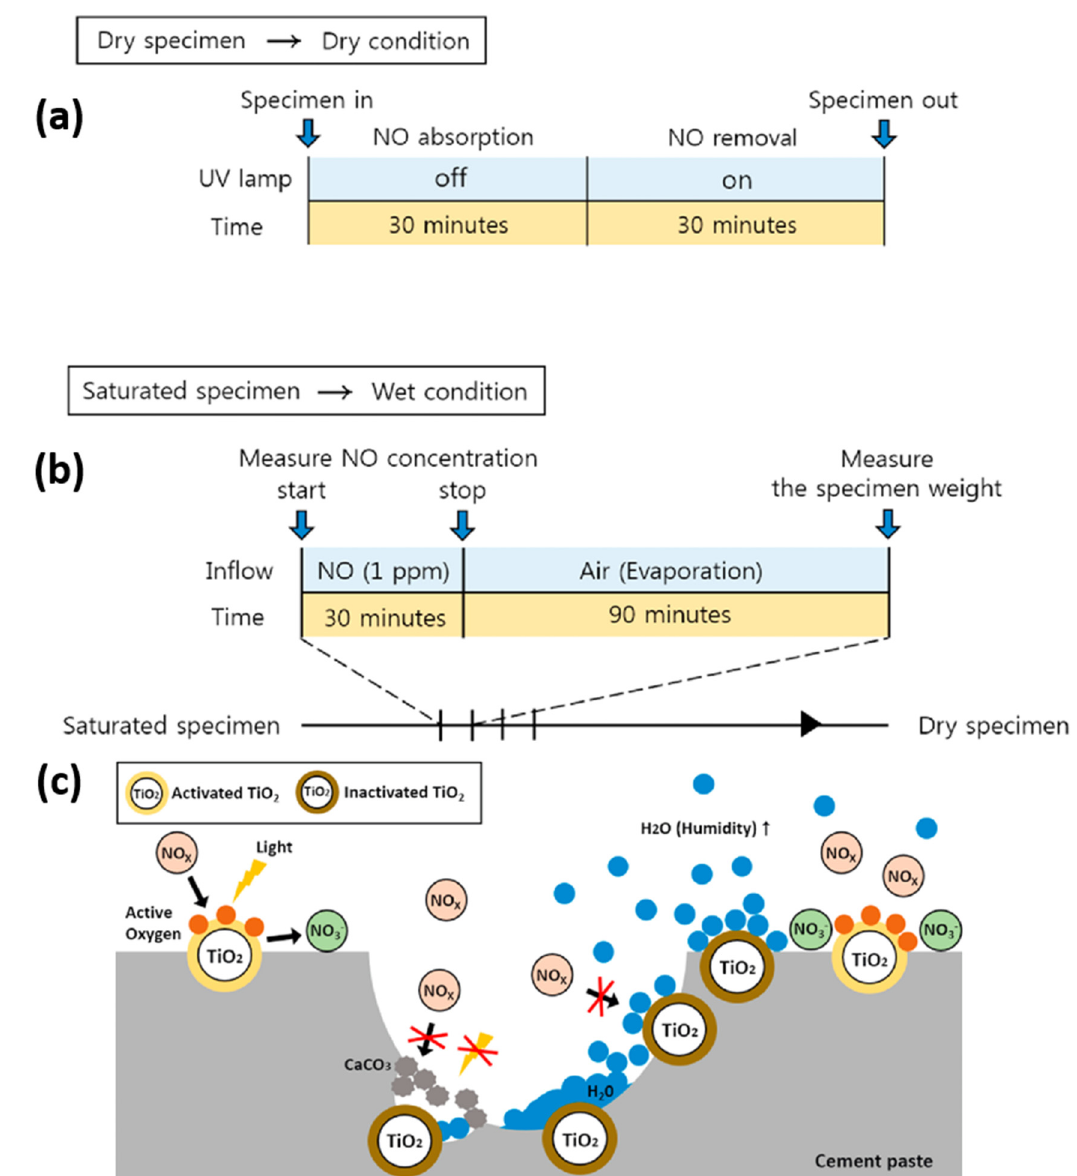
Figure 3. Experimental schemes of ( a ) dry and ( b ) wet condition test and ( c ) photocatalytic cement-based materials (wet conditions) [113] .